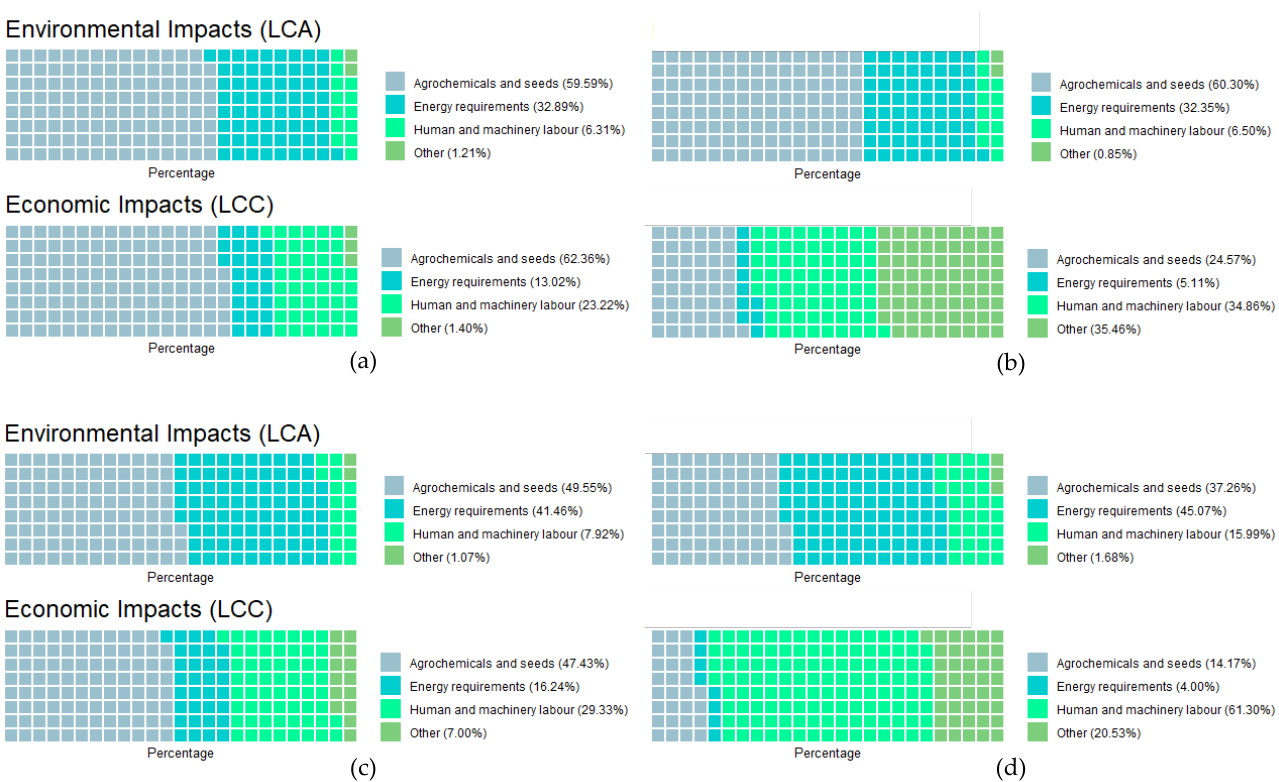
Figure 4. Waffle charts comparing the shares of impacts in LCA and LCC for: ( a ) Barley fodder ( b ) Olive trees, ( c ) Barley and olive trees and ( d ) Vetch–Barley and olive trees.